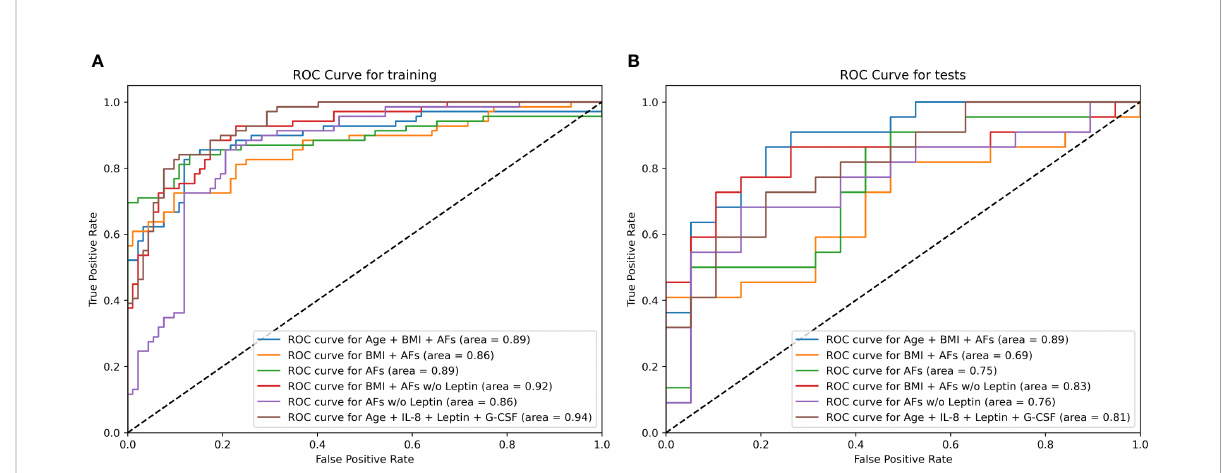
FIGURE 5 Receiver Operating Characteristic (ROC) curve for the six fi nal multivariate models on the training (A) and test (B) dataset calculated using the cross-folding method, as described in Section 2.4. (A) The curve shows that all multivariate models were able to discern between case and control group on the training dataset with relatively good results (AUC > 0.85). (B) Most models utilizing multiple features were able to generalize to unseen data and maintained a relatively robust classi fi cation performance with ROC AUC > 0.80. The model utilizing a combination of all AFs, BMI and age reached an ROC AUC of 0.89 on both the training and test dataset.